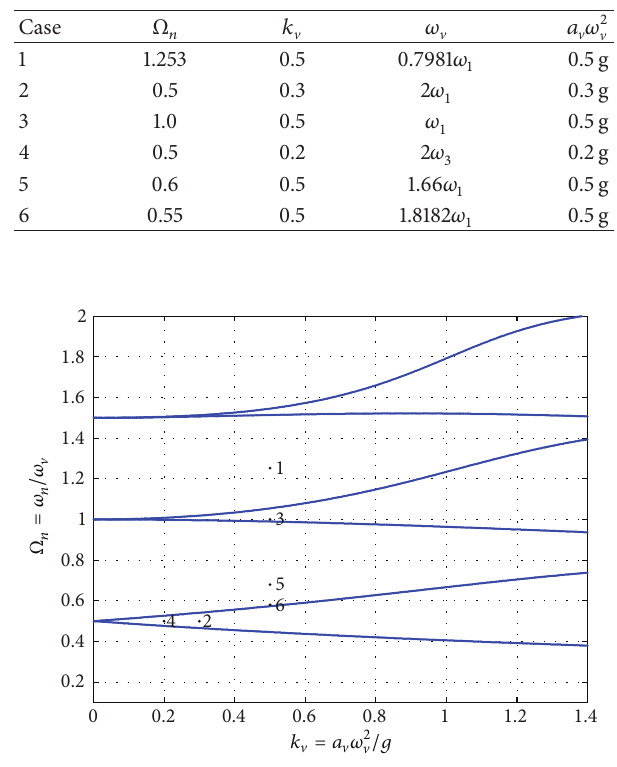
Figure 4: Stability chart of sloshing response under vertical excita- tions (test cases are also